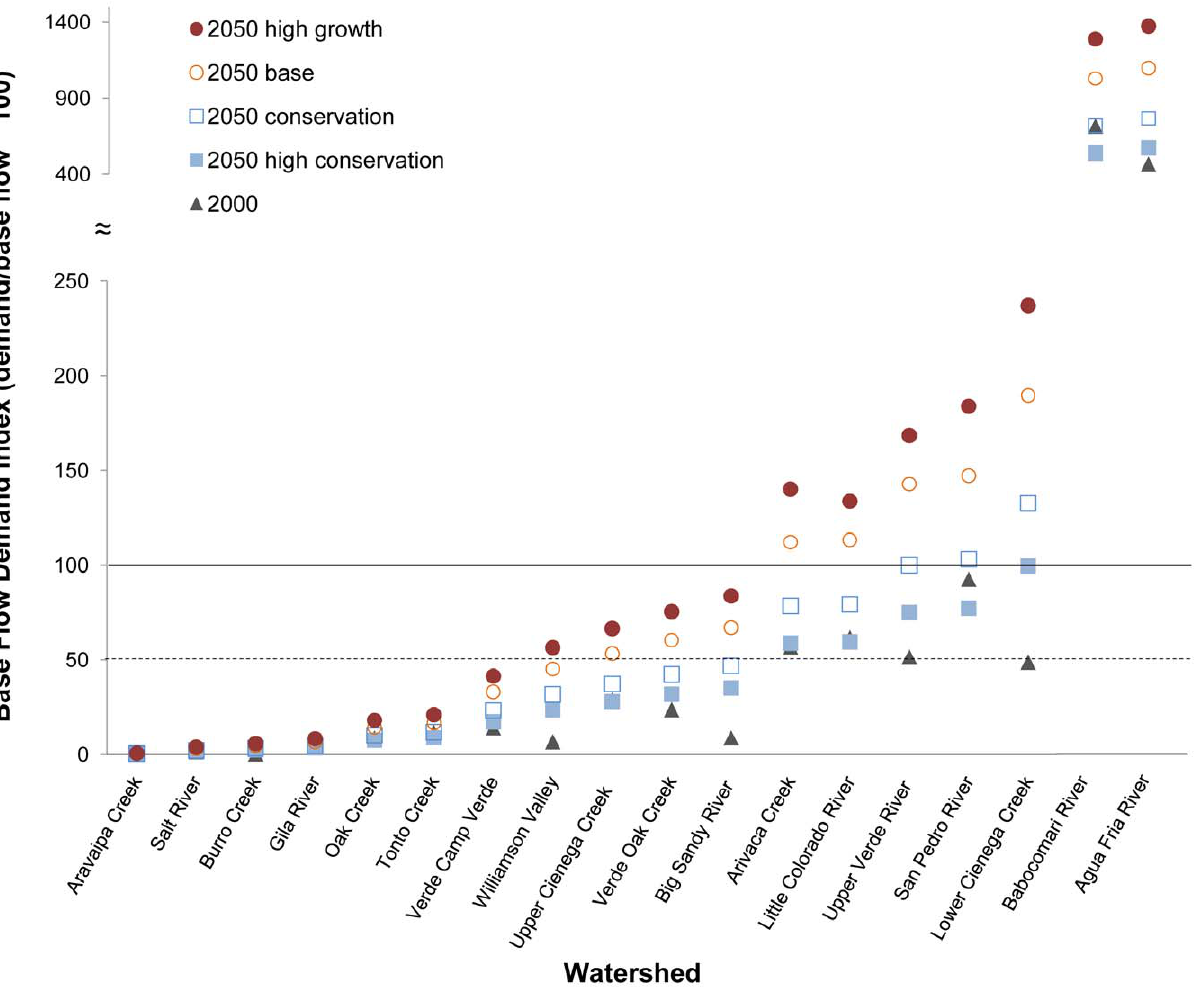
Figure 2. Base flow demand index (BDI) for 18 watersheds for the year 2000 and across four future scenarios. BDI is calculated as the percentage of municipal water demand to river base flow within a watershed. The solid horizontal line indicates the threshold where demand exceeds 100% of base flow; the dashed line delineates the transition from low BDI ( # 50% of base flow) to stressed BDI ( . 50%–100% of base flow). See text for description of